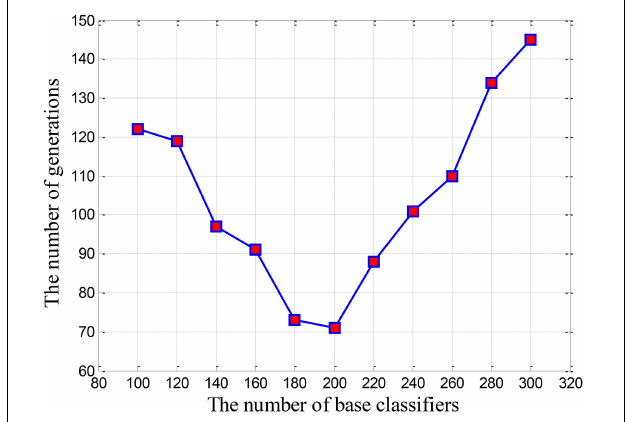
FIGURE 3 | The relationship curve between the evolutionary times and the quantity of base classifiers.